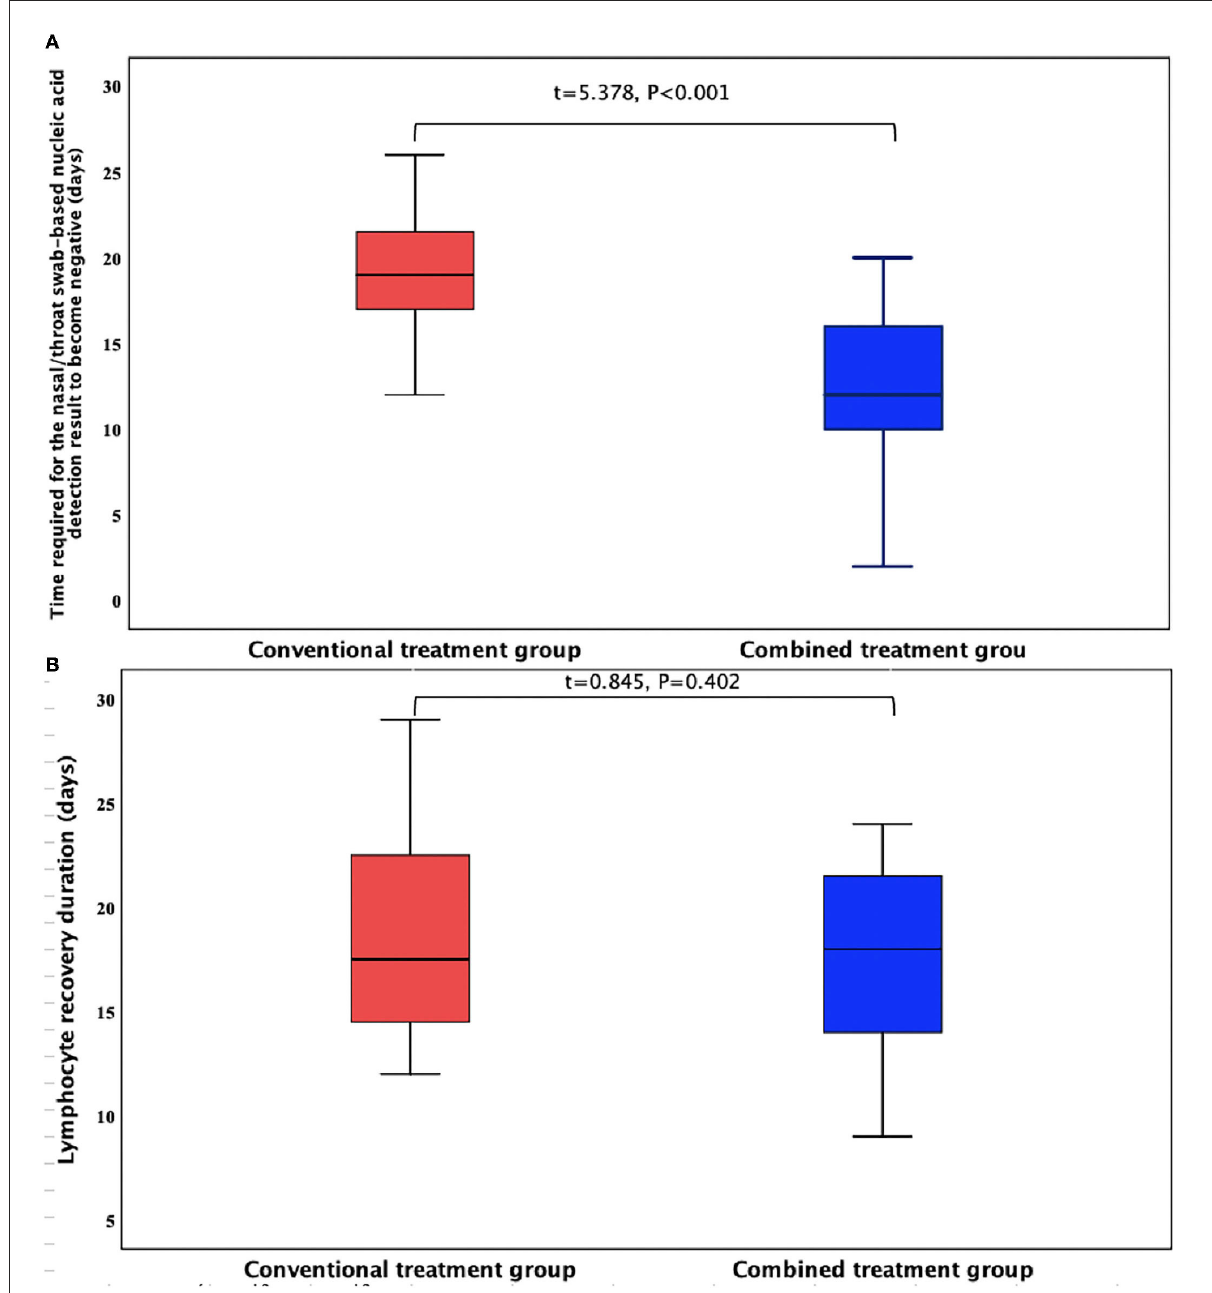
FIGURE1 Comparison of the main experimental indexes of the two patient groups. (A) Time required for the nasal/throat swab-based nucleic acid detection result to become negative (days); (B) Lymphocyte recovery duration (days).